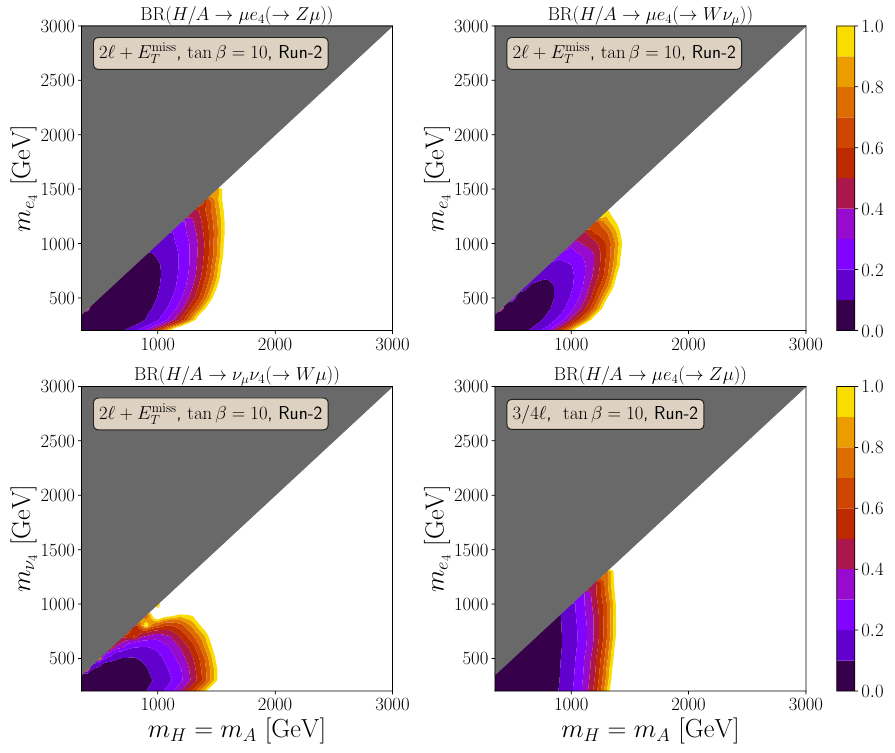
Figure 8 . Current upper bounds on the branching fractions when tan β = 10